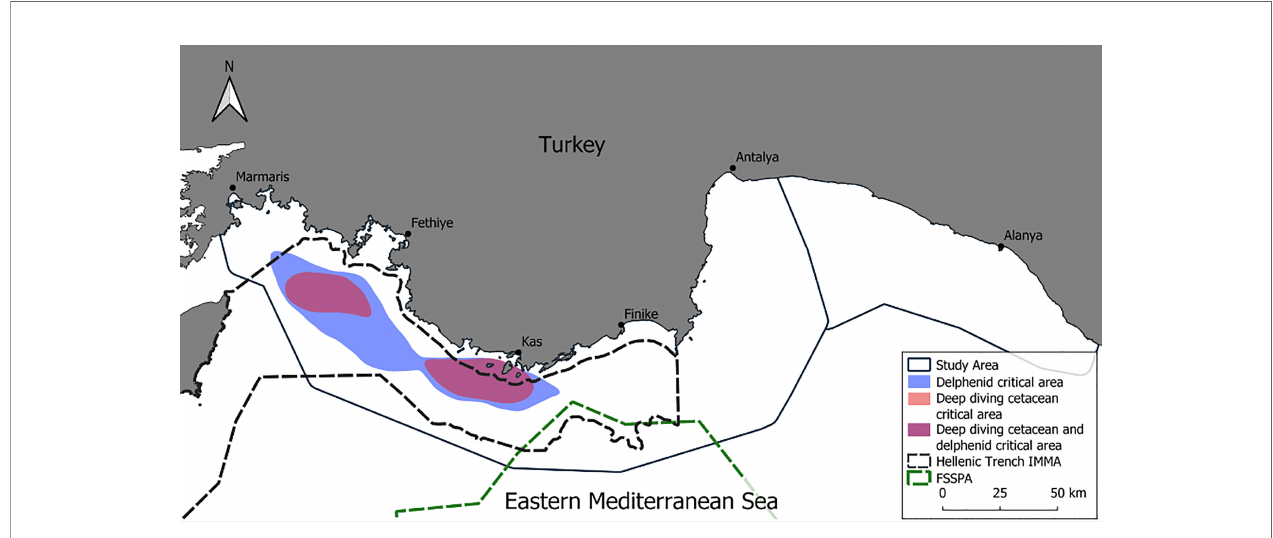
FIGURE 5 | Areas of the Eastern Mediterranean Sea surrounding Turkey deemed critical for delphinids (blue) and deep diving cetaceans (pink). Note that both critical areas for deep diving cetaceans fell within the critical area for delphinids and thus are shown in a purple